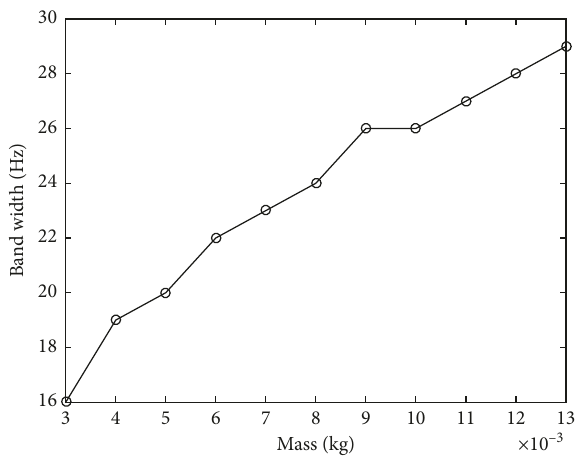
Figure 16: Bandwidth vs. square